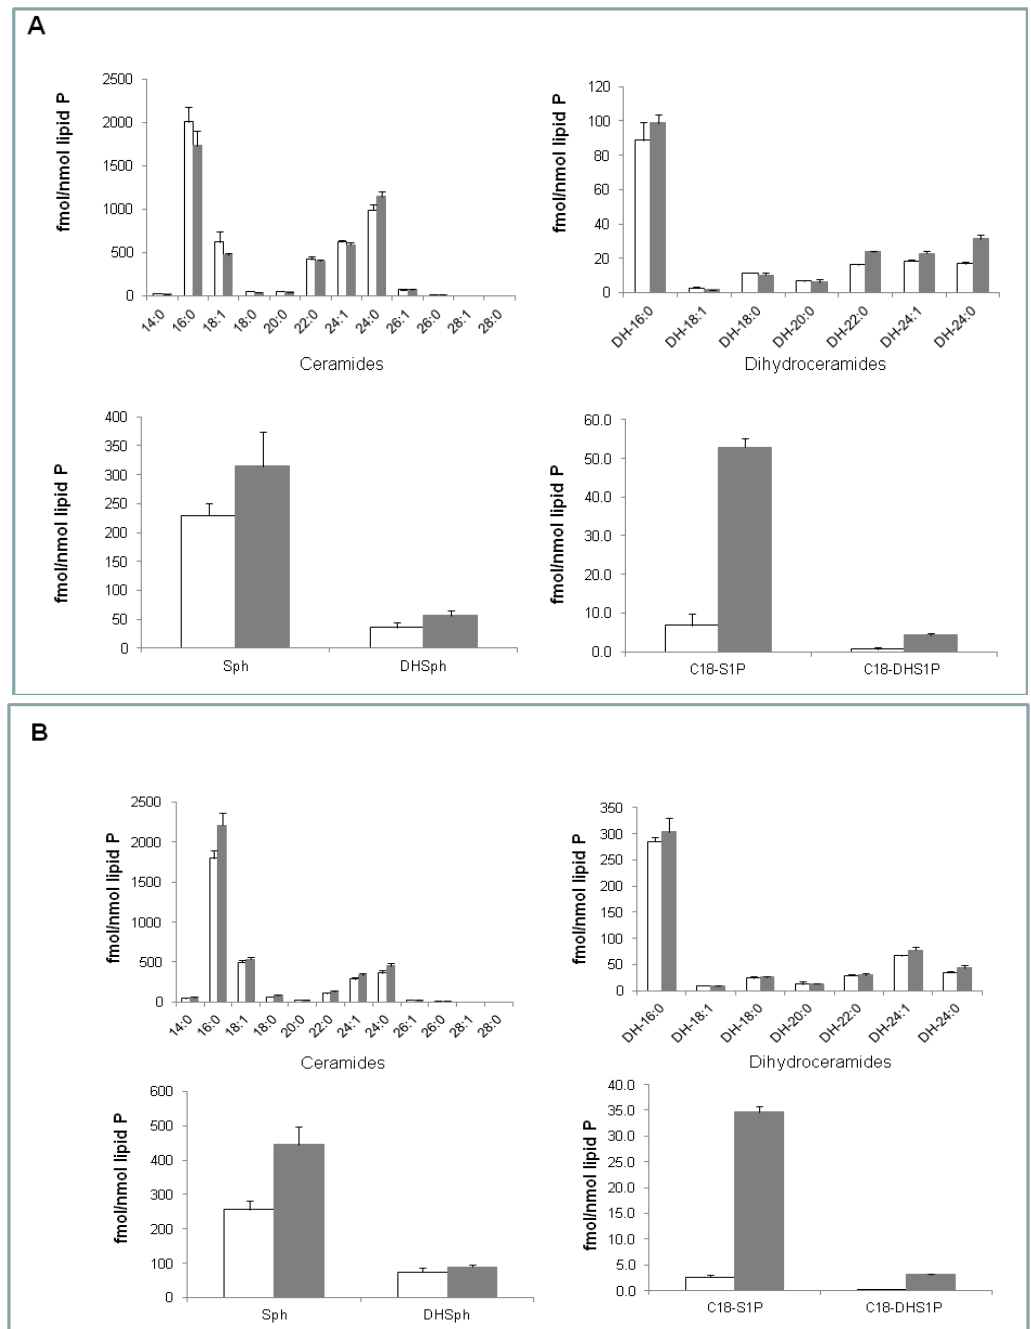
Figure 1. ( A ) Effect of ( S )-FTY720 vinylphosphonate on sphingolipid levels in LNCaP cells. P values for treated versus control, DH 22:0, 24:1 and 24:0, p < 0.01; C18-DHS1P, p < 0.01; S1P, p < 0.001; ( B ) Effect of ( S )-FTY720 vinylphosphonate on sphingolipid levels in LNCaP-AI cells. P values for treated versus control, C16:0 ceramide, p < 0.02; sphingosine, p < 0.01; DHS1P or S1P, p < 0.001. In both cases, cells were treated with ( S )- FTY720 vinylphosphonate (10 μM, 24 h, shaded bar) or with vehicle (DMSO, 0.1% v/v, 24 h, open bar) alone and samples subjected to LC-MS/MS analysis. Results are means +/− SD for n = 3